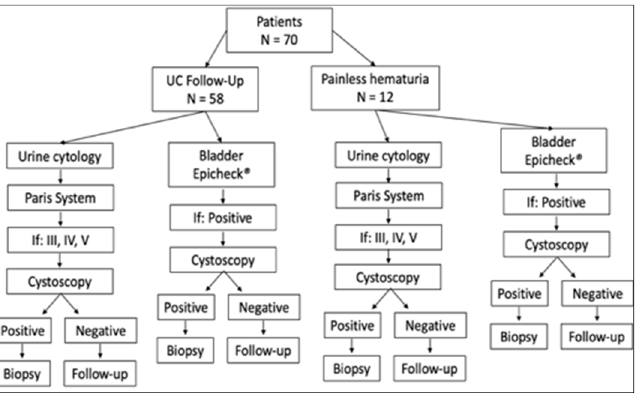
Figure 1. Distribution and workflow for patients included in the present study (N = 70) . UC: Urothelial carcinoma.